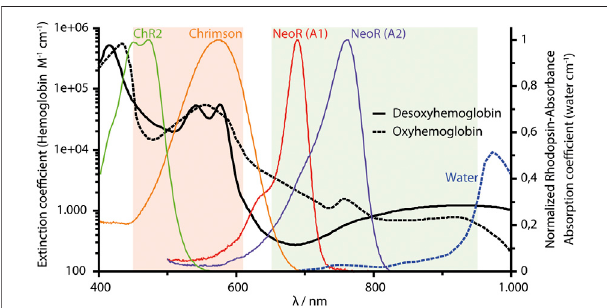
FIGURE 1 | NIR-window of biological tissue (650 – 950 nm, indicated as olive area). The spectral range (450 – 610 nm) of microbial rhodopsin shown orange, and absorption spectra of two ChR (ChR2 and Chrimson) commonly used in optogenetics. NeoR absorption (red absorbing-state) with either